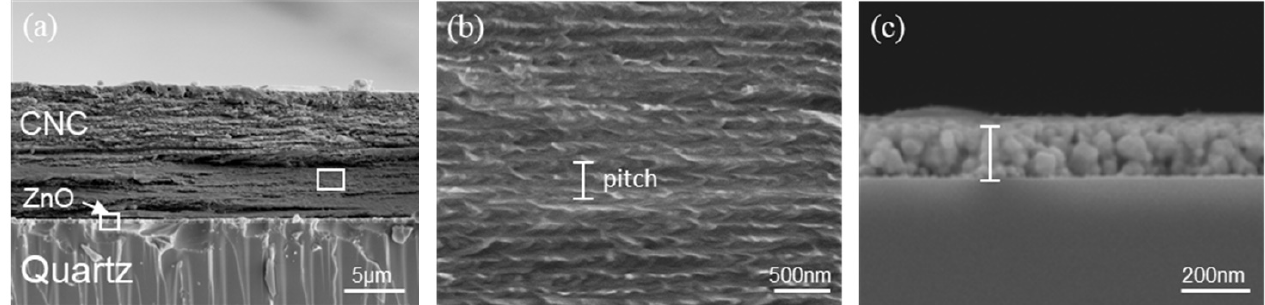
Figure 2. SEM of a cross-section of ( a ) CNC/ZnO photodetector, ( b ) CNC layer and ( c ) ZnO layer.